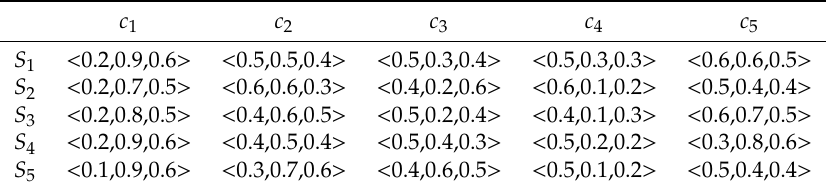
Table 1. Decision matrix.